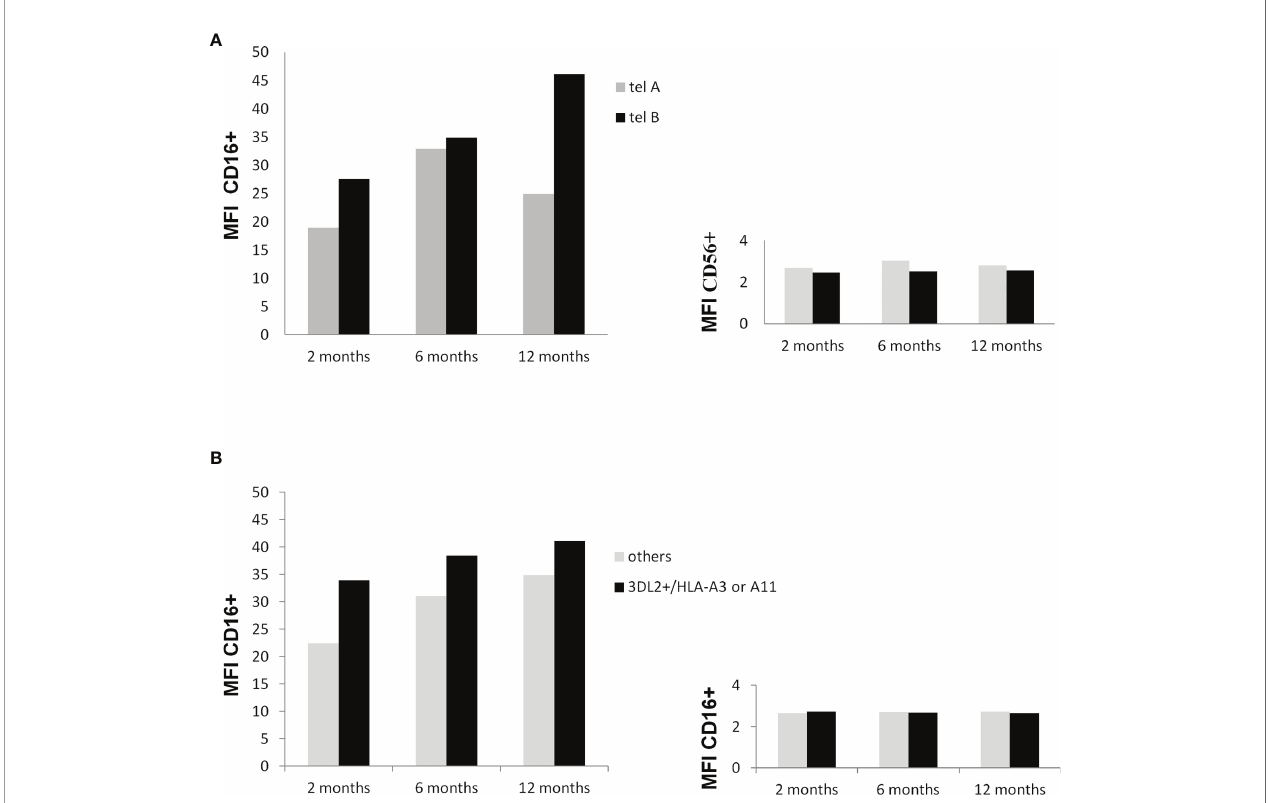
FIGURE 5 | (A) In fl uence of the KIR tel B genotype on CD16 and CD56 membrane expression at 2, 6, and 12 months after surgery. Mononuclear peripheral blood cells from KIR tel genotyped patients (n=10) were labeled with anti-CD3 and anti-CD16 monoclonal antibody and anti-CD56 antibody and analysed by fl ow cytometry. An increase in the expression of CD16 on NK cells carrying the tel B genotype was found during time (trend P=0.11) (A) In fl uence of the potential functional KIR3DL2+/HLA-A*03 or A*11 gene combinations on CD16 and CD56 membrane expression at 2, 6, and 12 months after surgery. Mononuclear peripheral blood cells from KIR tel genotyped patients were labeled toghther with anti-CD3, anti-CD16 , and anti-CD56 antibodies and analysed by fl ow cytometry. Differences among groups were not statistically signi fi